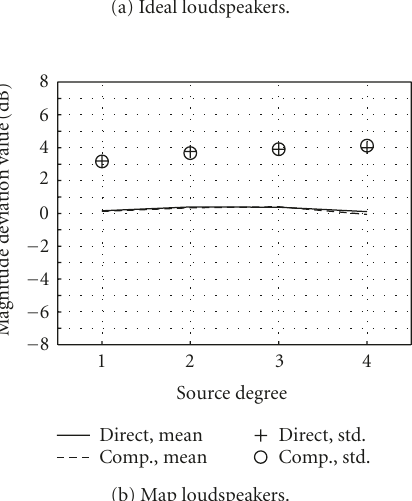
Figure 16: Mean value and standard deviation of MAG Ψ ated below the aliasing frequency for all microphone and source positions. Synthesis of rotated elementary directivity function (see (22)). Comparison between recomposition from elementary direc- tivity (comp) and direct synthesis (direct). All filters are calculated using multichannel equalization (Meq).